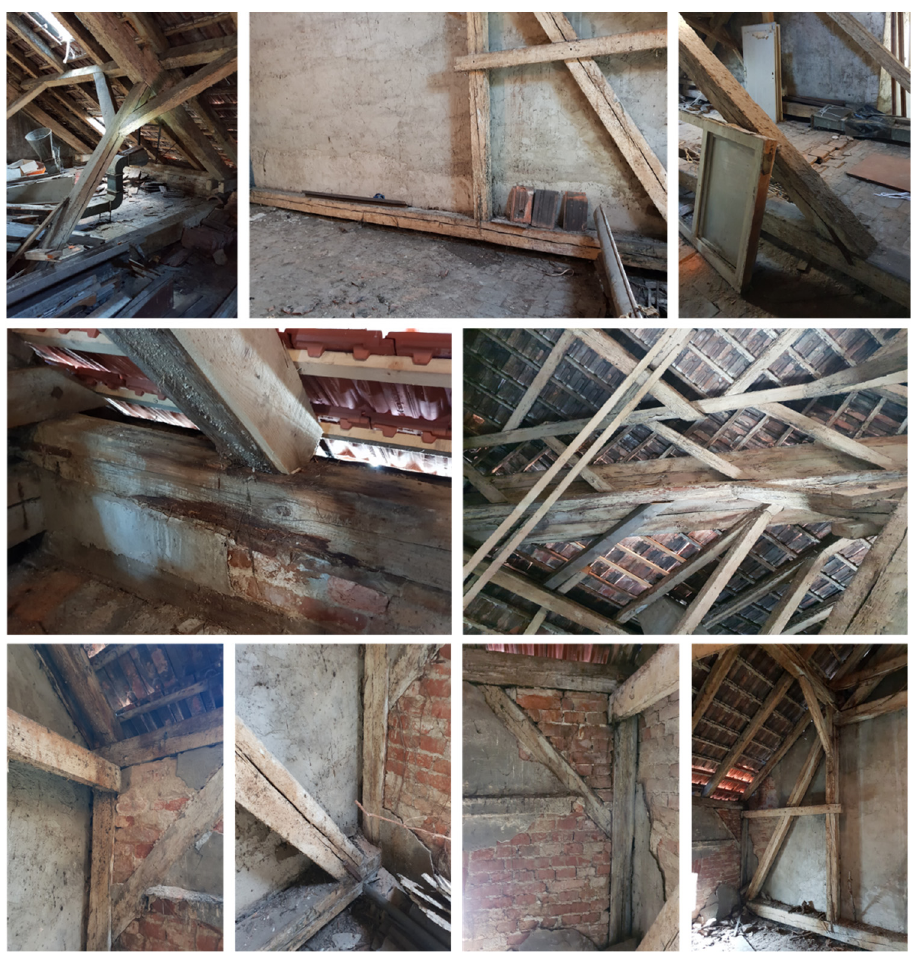
Figure 15. Overview of typical element damage (arranged in order): POZ16, POZ 11, and POZ23; POZ1 and POZ5; POZ9 and